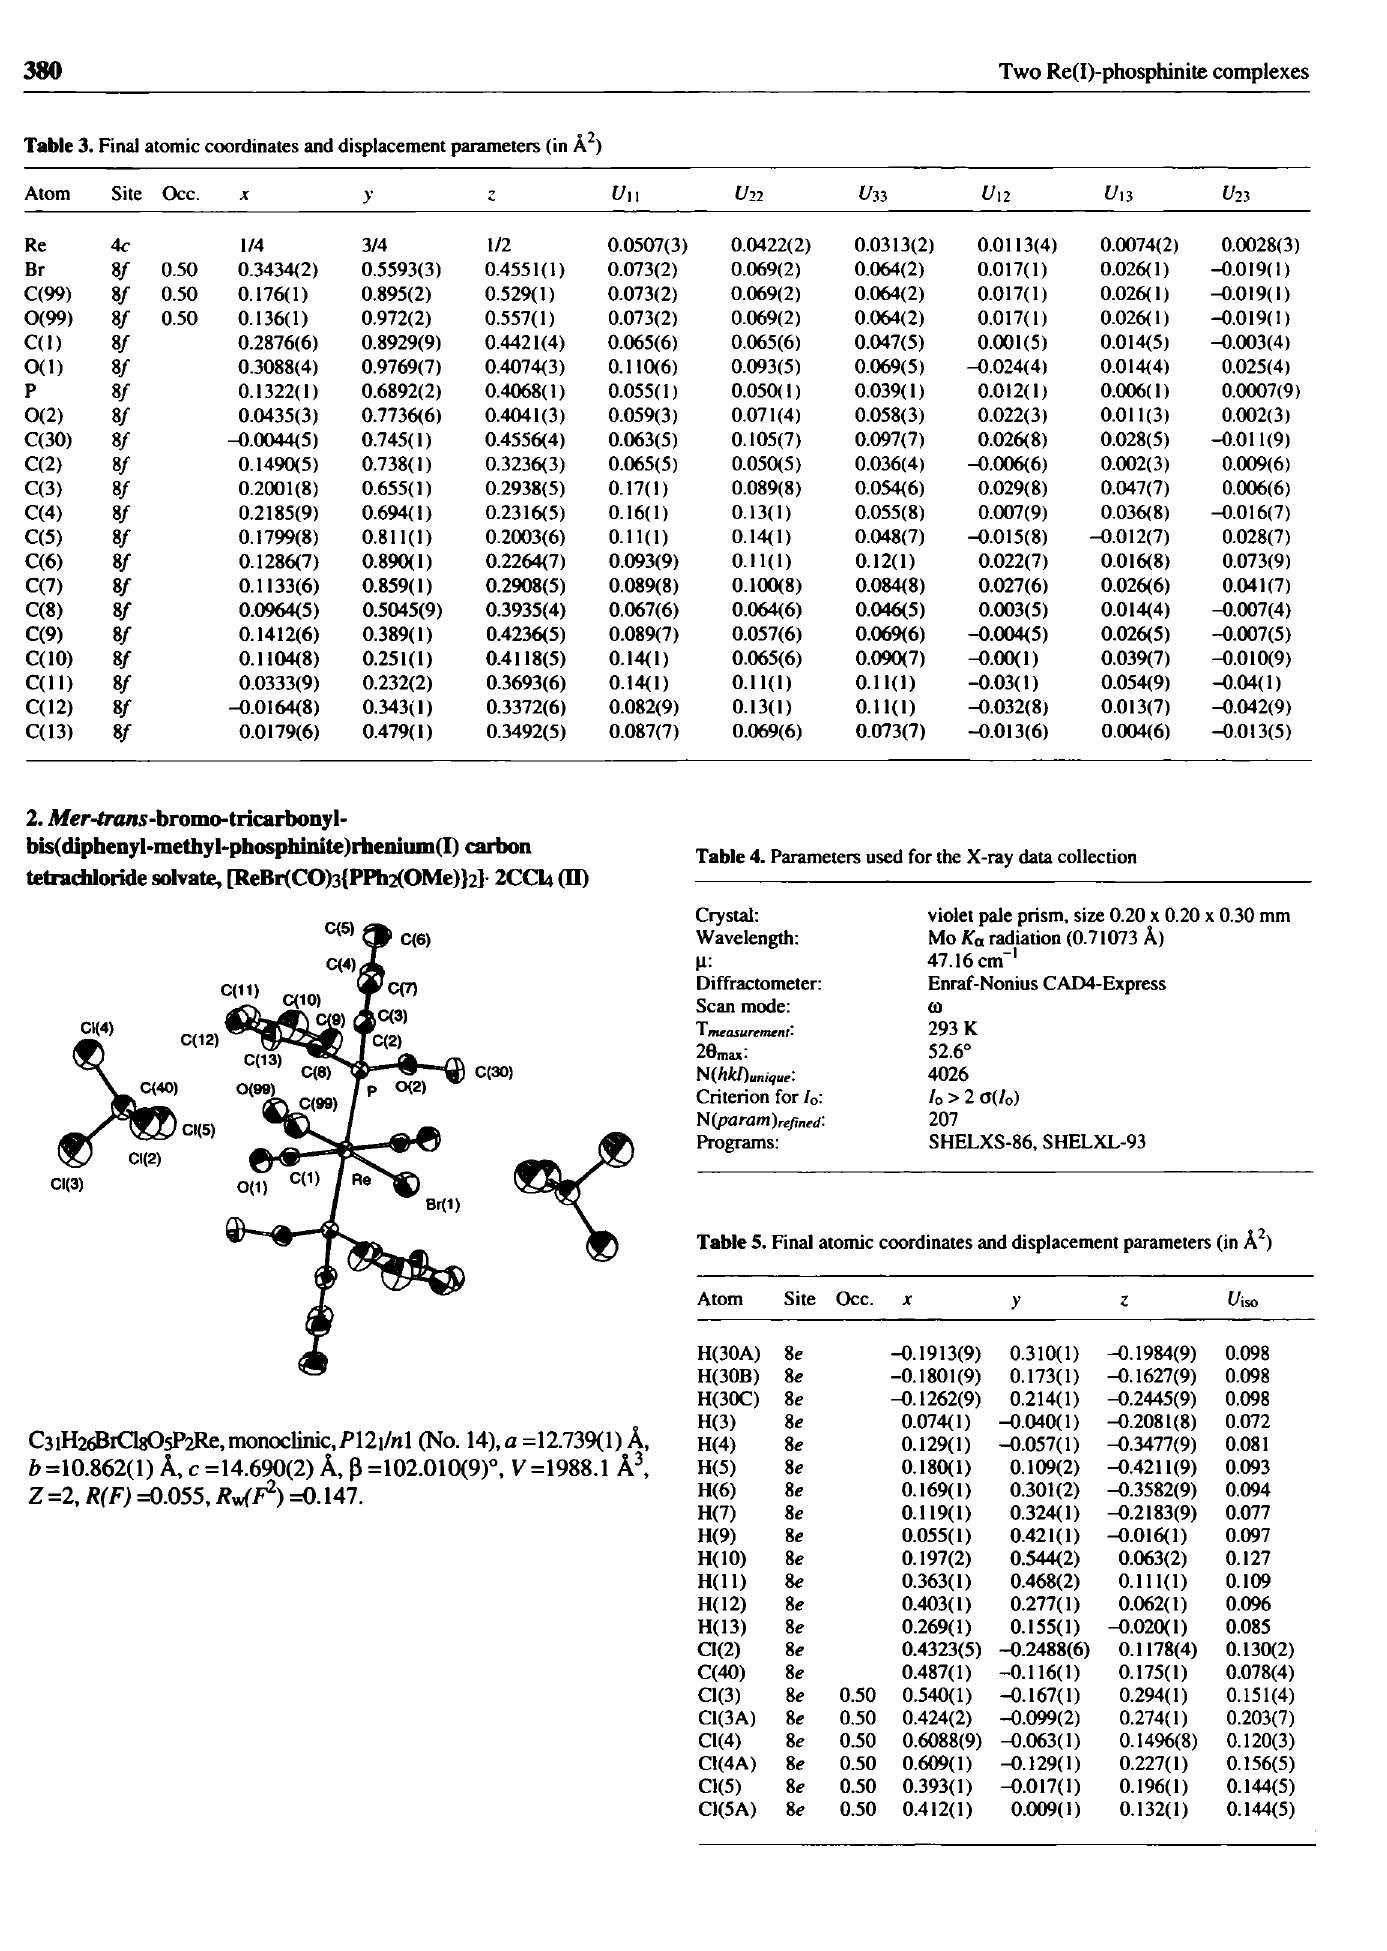
Table 5. Final atomic coordinates and displacement parameters (in